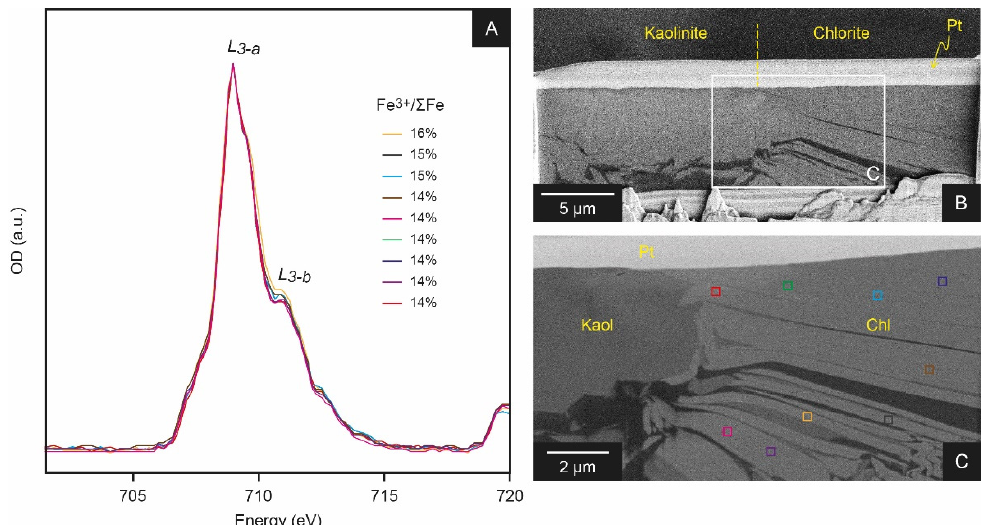
Figure 12. ( A ): Representative X-ray absorption spectra of chlorites, measured in transmission mode (STXM, SLS) at the Fe L 3 -edge. Based on the protocol of Bourdelle et al. [26]. The calculated average Fe 3+ /Fe tot ratio is ~14% for all analysed chlorites. ( B ): SEM image of the FIB-section cut through the kaolinite/chlorite contact. ( C ) image is located. Pt: platinum, added before cutting the FIB-section to protect it. ( C ): location of the STXM-XANES analyses into chlorite, each square referring to one spectrum.